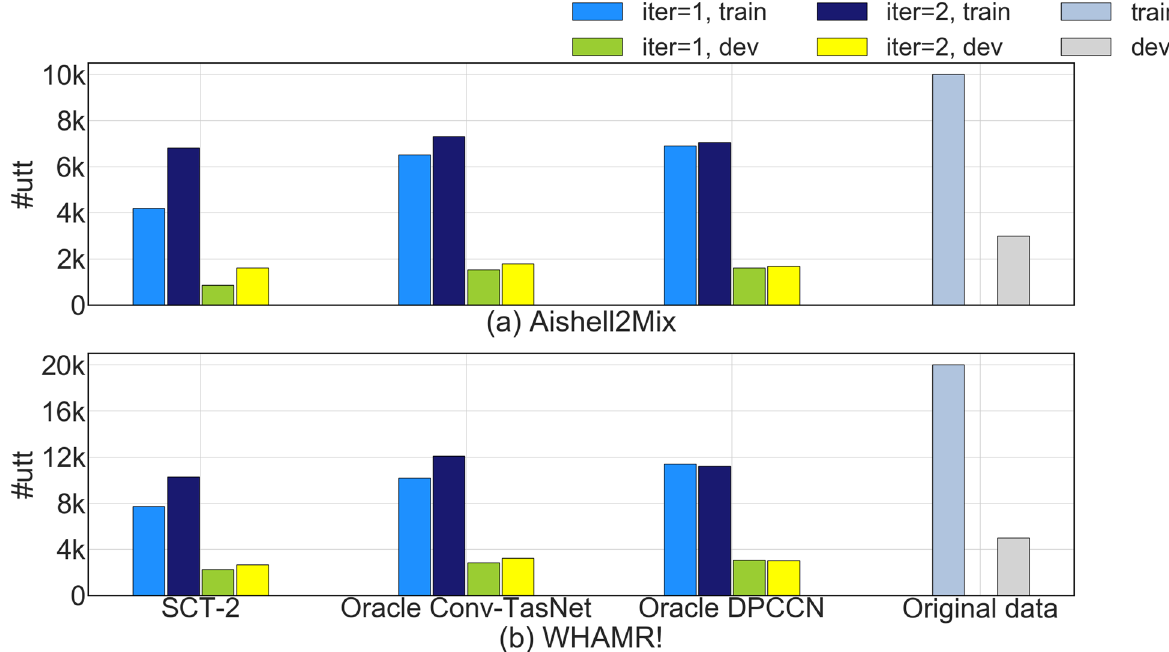
Fig. 3 Data quantity of selected pseudo ground-truth of SCT-2 (with CPS-2) versus the “Oracle selection” on Aishell2Mix and WHAMR! unlabeled training and development